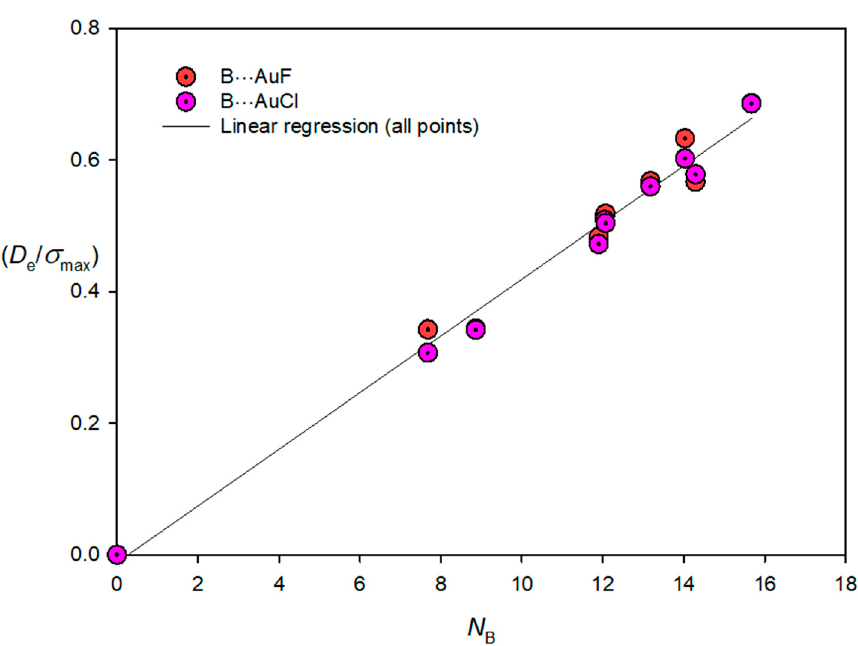
Figure 7. Normalised D e values ( D e / σ max ) plotted against the nucleophilicities of the Lewis bases B for 18 complexes B···AuX (X =F and Cl). The straight line is the linear regression fit to all 18 points and has the equation ( D e / σ max ) = [4.31(11) × 10 − 2 ] N B − 0.011(13), with R 2 = 0.9876. Several of the AuF and AuCl points are obscured by